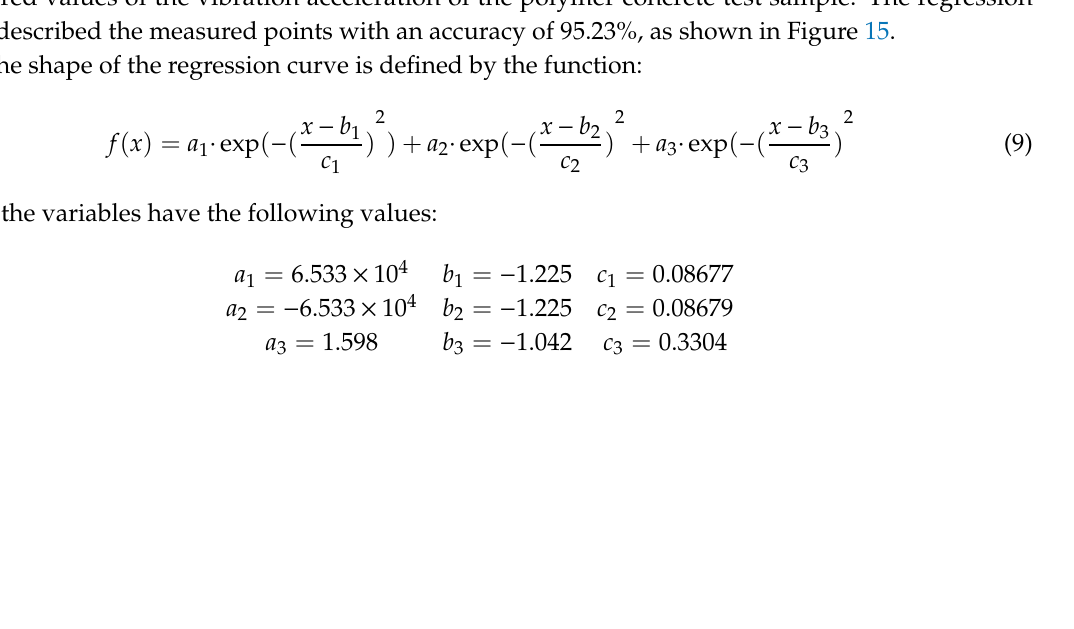
Figure 15. Gaussian regression curve. The shape of the regression curve is defined by the function: 𝑓(cid:4666)x(cid:4667) = 𝑎 (cid:2869) . exp (cid:4666)−(cid:4666) 𝑥 − 𝑏 (cid:2869) 𝑐 (cid:2869) (cid:4667) (cid:2870) (cid:4667) (cid:3397) 𝑎 (cid:2870) . exp (cid:4666)−(cid:4666) 𝑥 − 𝑏 (cid:2870) 𝑐 (cid:2870) (cid:4667) (cid:2870) (cid:3397) 𝑎 (cid:2871) . exp (cid:4666)−(cid:4666) 𝑥 − 𝑏 (cid:2871) 𝑐 (cid:2871) (cid:4667) (cid:2870)